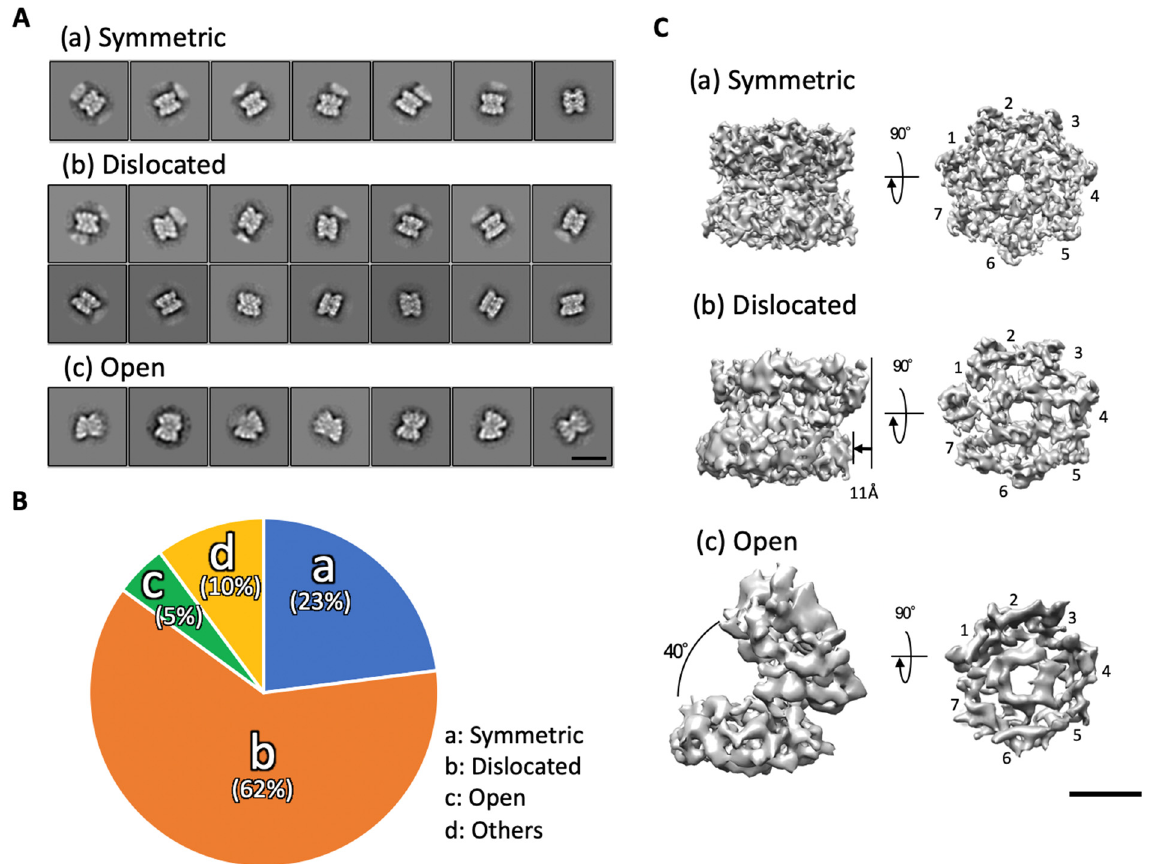
Figure 1. Single particle cryo-EM analysis of the α 7 homo-tetradecamer. ( A ) Representative 2D class average images of the three types of the α 7 homo-tetradecamer: ( a ) symmetric, ( b ) dislocated, and ( c ) open. Scale bar, 100 Å. ( B ) Ratio of each type of the α 7 homo-tetradecamer classified by 2D classification ( a – c ). Others ( d ) include intermediate particles between each type, broken particles, or unknown particles. ( C ) 3D reconstructions of the three types of the α 7 homo-tetradecamer. Scale bar, 50 Å.